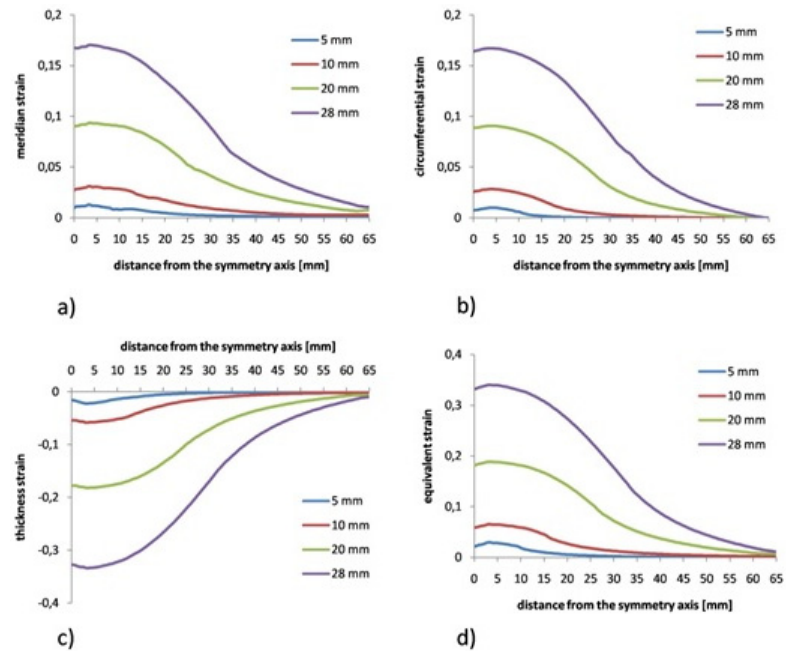
Figure 3. Distribution of the main strains and equivalent strain during the stretching process in perfect lubrification condition due to FEM: ( a ) meridian strain; ( b ) circumferential strain; ( c ) thickness strain; ( d ) equivalent strain.